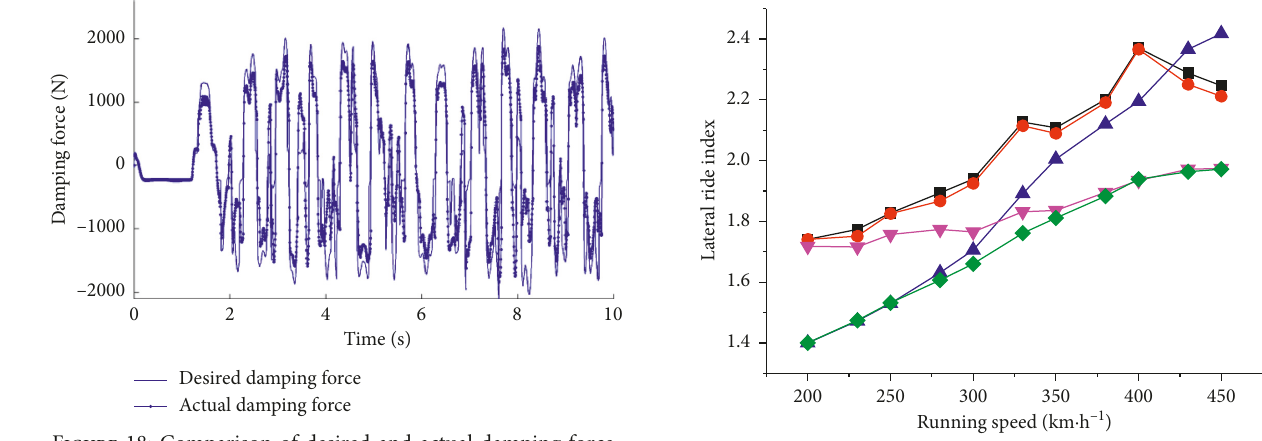
Figure 18: Comparison of desired and actual damping force.